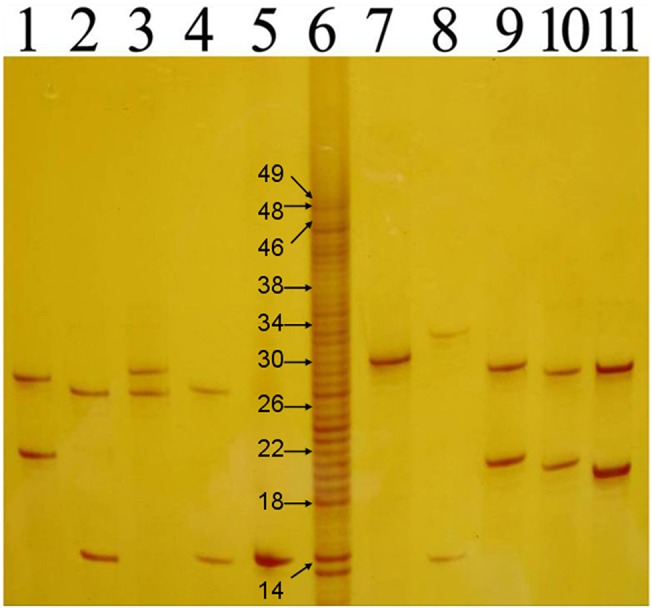
The polyacrylamide gel electrophoresis analysis of ANs and the CAG repeat ladder.Lanes 1–6 and 8–12 were ANs; lane 7 was the CAG repeat ladder. The CAG repeat numbers of the ladder’s bands were 13, 14, 18–43, 45, 46, 48 and 49. The bands contained 14, 18, 22, 26, 30, 34, 38, 46, 48 and 49 CAG repeats were marked by specific number.